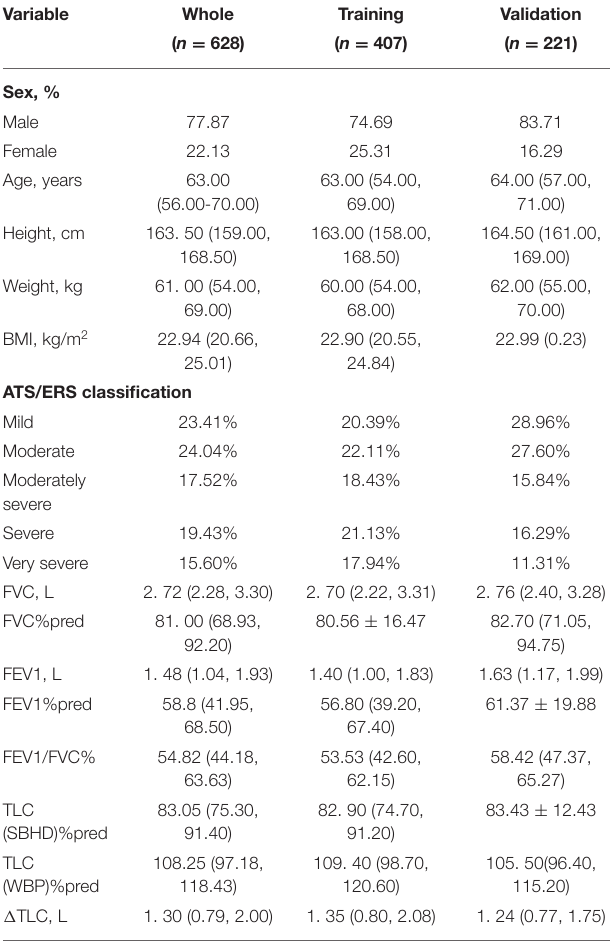
TABLE 1 | Anthropometric characteristics and functional parameters in the 628 subjects.